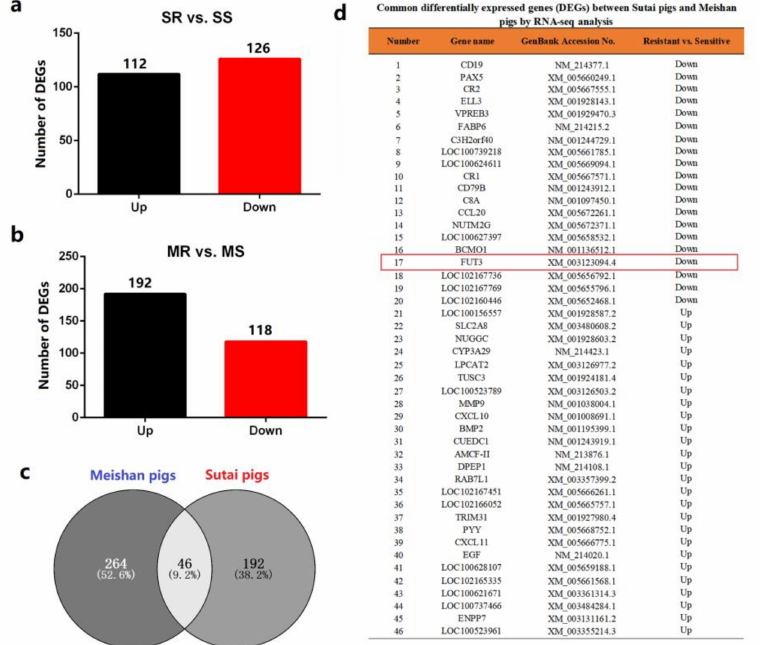
Figure 1. Pig FUT3 is found as a host gene involved in the infection of E. coli F18. ( a ) DGEs between Sutai F18-resistant (SR) and -sensitive (SS) piglets. ( b ) DGEs between Meishan F18-resistant (MR) and -sensitive (MS) piglets. ( c ) Venny screening of common DGEs between Sutai and Meishan piglets. ( d ) Gene list of common DGEs has been associated with infection caused via E. coli (F18).